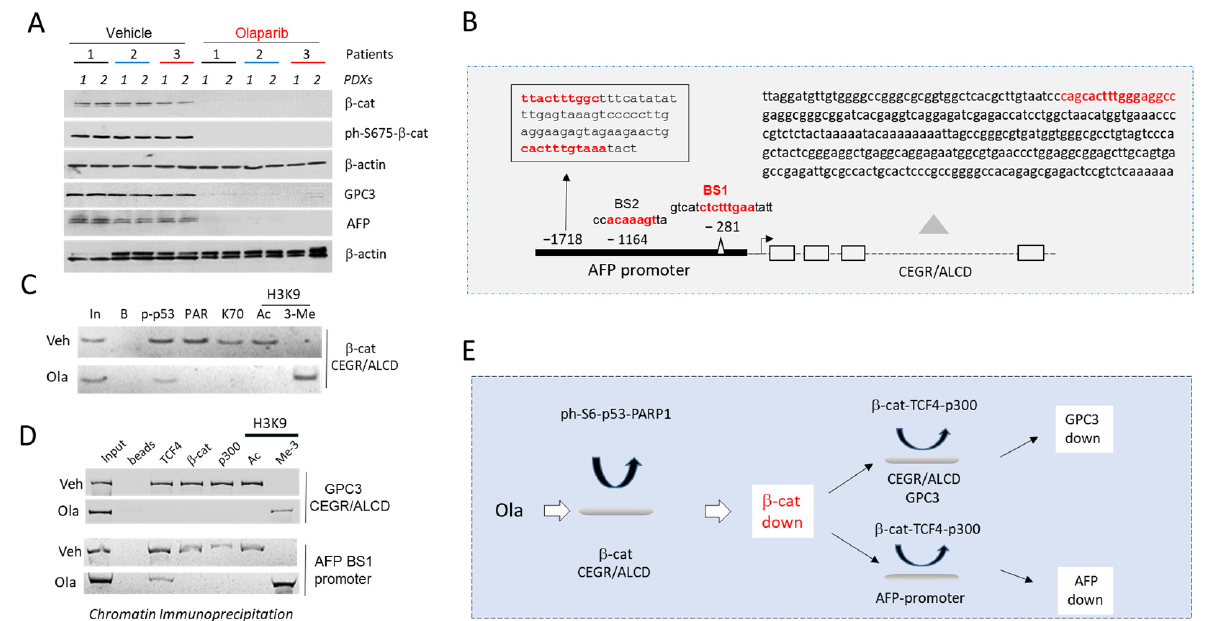
Figure 7. Repression of CEGRs/ALCDs in HBL-derived PDXs inhibits expression of β -catenin, GPC3, and AFP in tumors and reduces secretion of AFP in bloodstream. ( A ) Levels of β -catenin, ph-S675- β -catenin, GPC3 and AFP in tumors of PDXs treated with vehicle and Olaparib (Ola). ( B ) Locations of CEGR/ALCD and TCF4-binding sites in the AFP gene. ( C ) Examination of ph-S6-p53-PARP1 complexes on the CEGR/ALCD of β -catenin gene by ChIP assay. ( D ) Examination of β -catenin-TCF4-p300 complexes on CEGR/ALCD of GPC3 gene and on AFP promoter by ChIP assay. ( E ) A diagram showing a cascade of CEGRs/ALCDs-dependent events in HBL-PDXs treated with Ola. The uncropped Western blots have been shown in Figure S9.